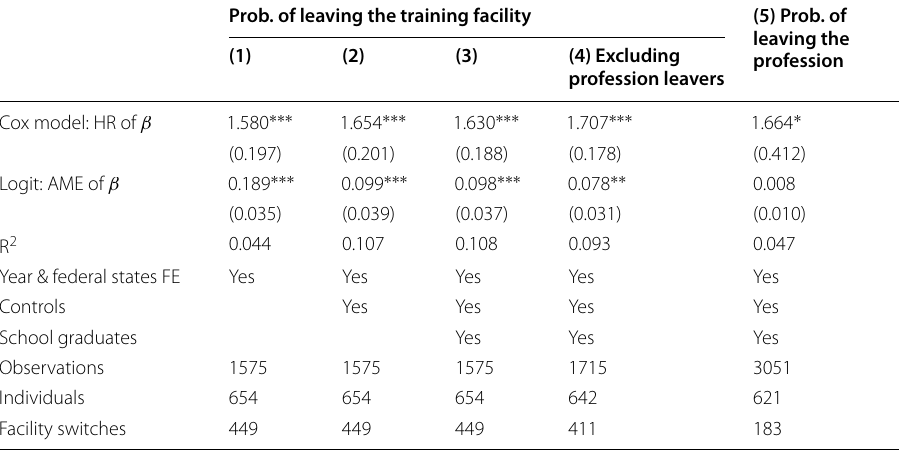
This table estimates Eq. (1) and presents the effect of the levy scheme on the probability of leaving the training facility (parameter β ). Estimates are performed by the Cox hazard model and by logit regressions. Throughout Models 1–3, we smoothly add covariates summarized in Table 1. In Model 4, we exclusively consider facility stayers and facility leavers who stick to the profession of geriatric nursing. Thus, we exclude graduates whose first new workplace after graduation does not belong to the profession of geriatric nursing. In Model 5, we only include graduates who stay at the training facility and graduates who both leave the training facility and the profession. Thus, in this model, we model the probability of leaving the profession after graduation of apprenticeship